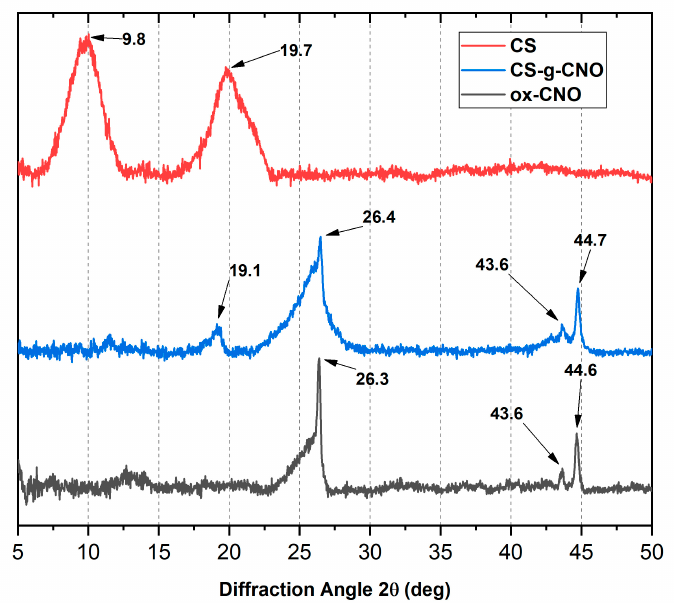
Figure 3. X-ray diffraction (XRD) analysis of CS (red line), CS-g-CNO (blue line), and ox-CNO (black line).